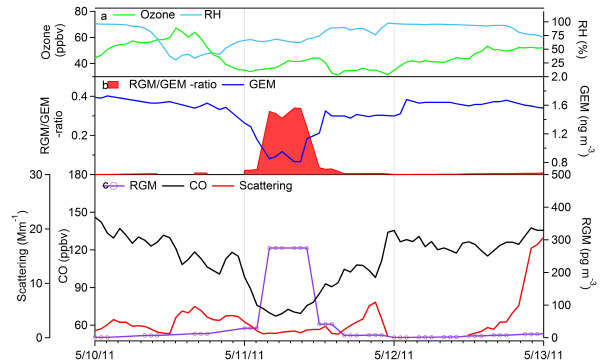
Fig. 7. Time series of (a) O 3 and relative humidity (RH); (b) RGM/GEM-ratio and GEM; (c) RGM, submicron aerosol scatter- ing ( σ sp ) , and CO measured at MBO during a type 3 (MBL) high- RGM event in spring 2011. All data are 1-h averages, except RGM and RGM/GEM-ratios that are 3-h averages (resolution of the RGM measurement). Measurements of RGM are plotted for each hour of